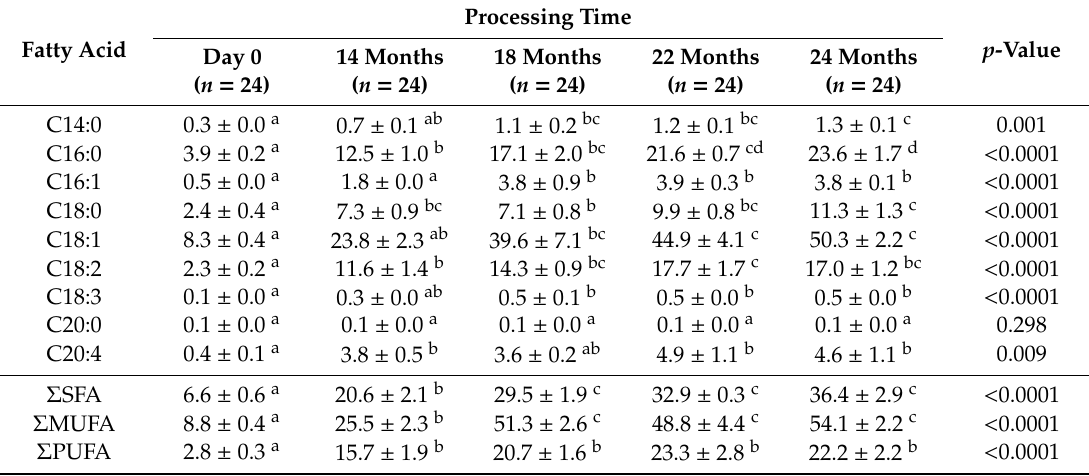
Table 4. E ff ect of processing time on free fatty acids contents in Chato murciano dry-cured ham. Results are expressed as g fatty acid methyl esters / Kg of intramuscular fat (means values ±